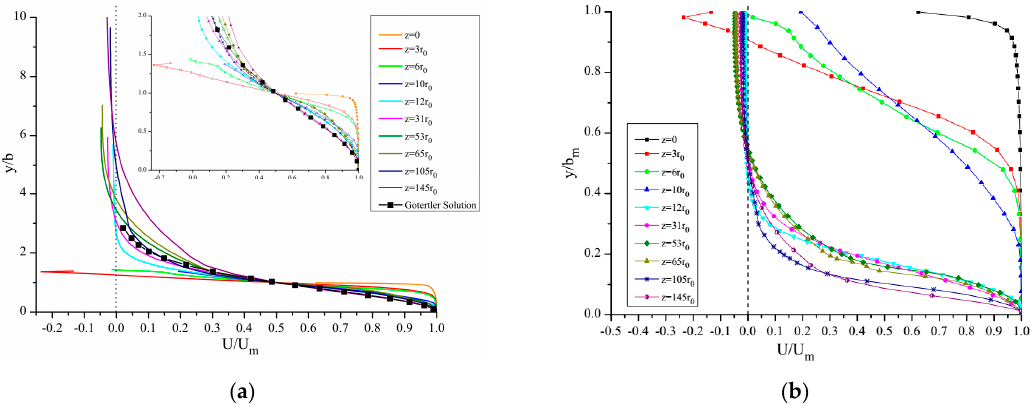
Figure 11. Distribution of cross-section dimensionless velocity vs. the Goertler solution. ( a ) η ≦ 1; ( b ) η > 1. ( b ) η >